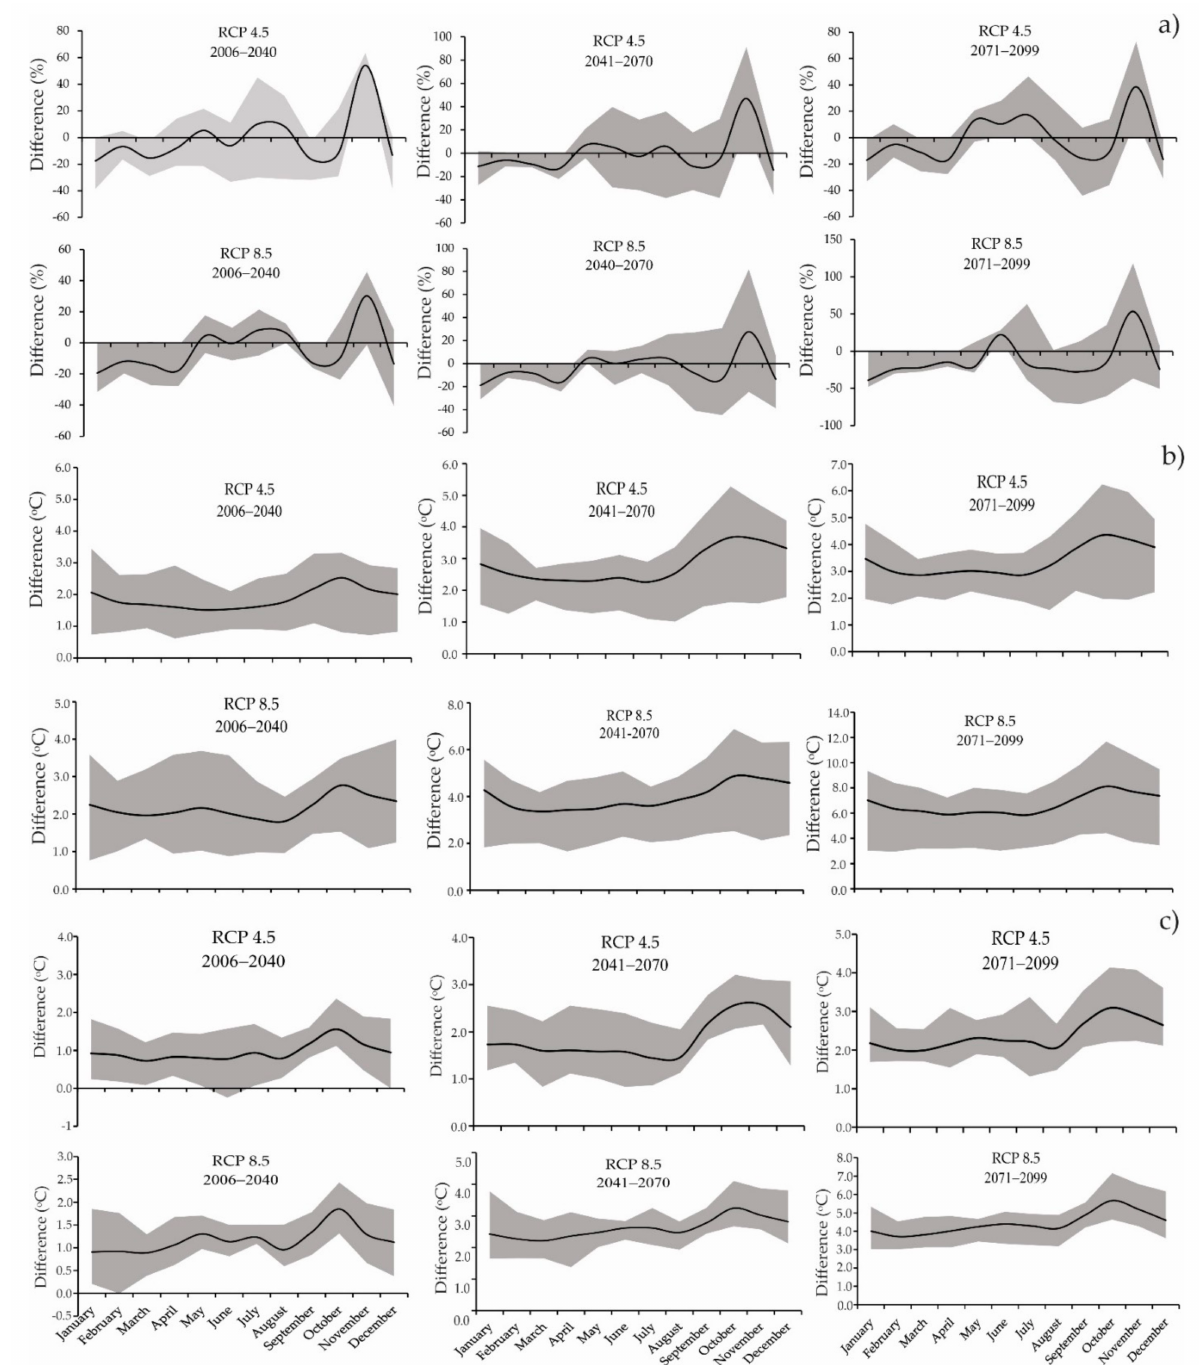
Figure 6. Changes in the monthly average precipitation (%) ( a ) and maximum ( b ) and minimum ( c ) temperatures (ensemble, black line) and respective ranges simulated by the RCMs under RCP4.5 and RCP8.5 for the GRB-Furnas throughout the XXI